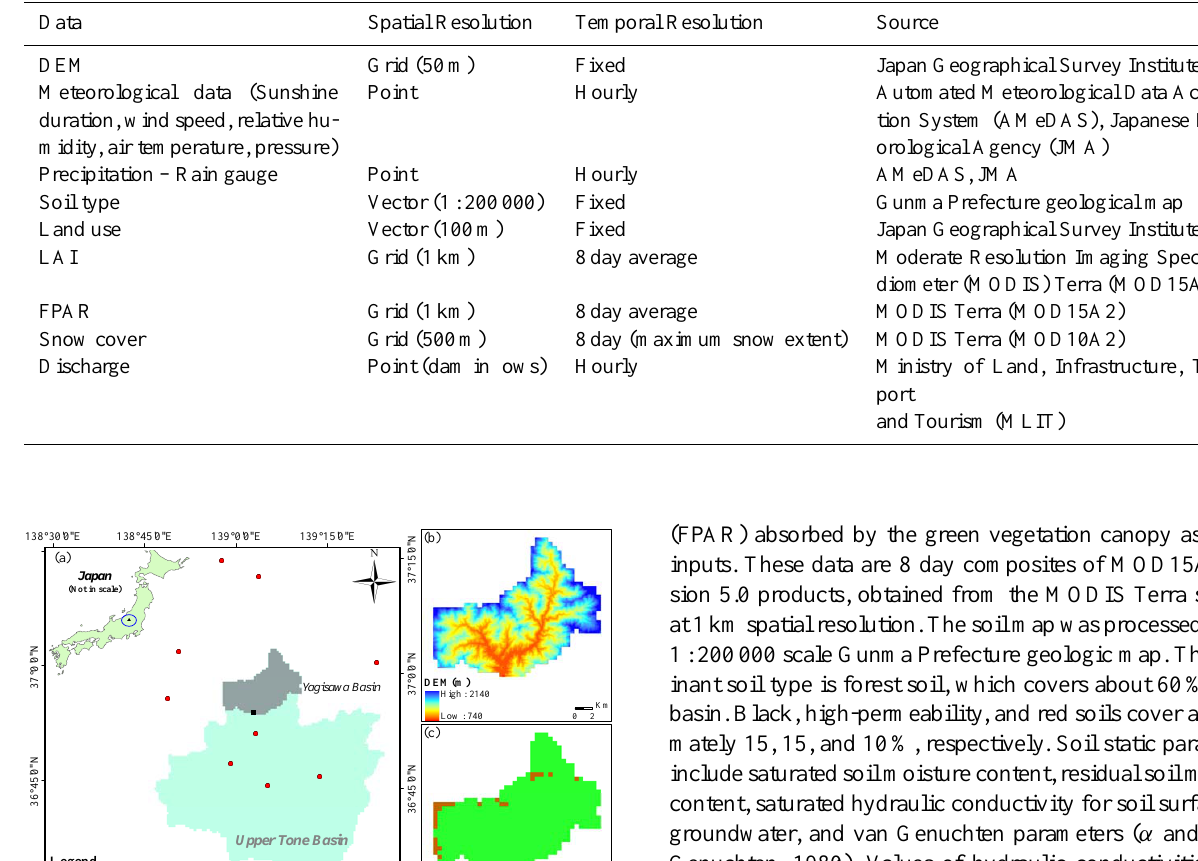
Table 1. Summary of dataset.